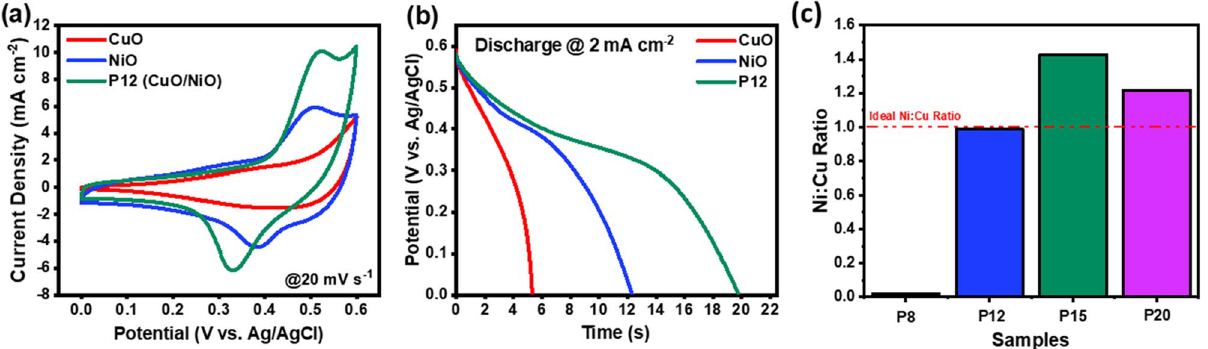
Figure 6. Analysis of synergistic effects by carrying individual analysis with same laser parameters as the best sample P12 ( a ) CV profile ( b ) GCD ( c ) Ni:Cu ratio identified through